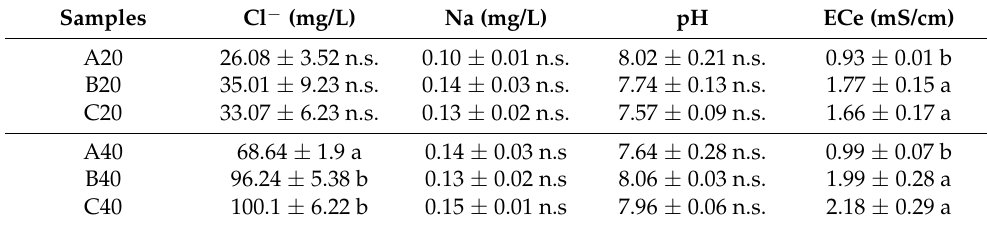
Table 6. Level of Na, Cl, pH and ECe of soil samples collected at two depths 0–0.2, 0.2–0.4. Each value is an average of 3 samples. Letters indicate statistically significant differences at p < 0.05 level of significance. n.s. indicates not